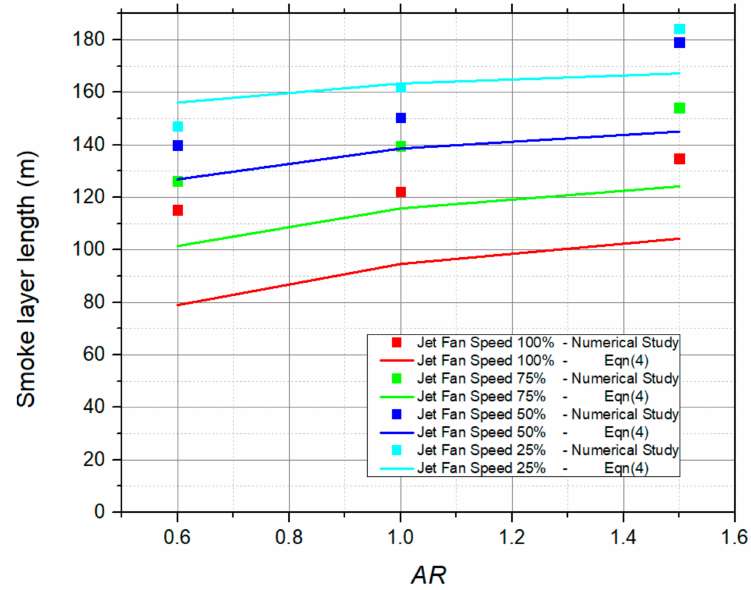
Figure 14. Smoke back layer length in relationship between AR and jet fan